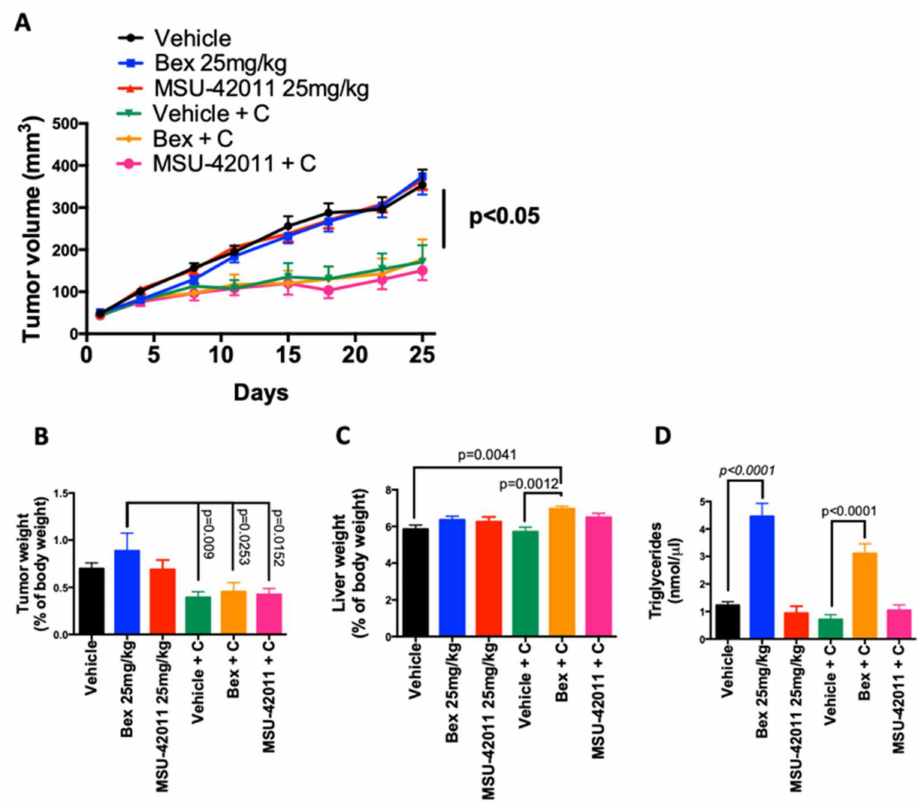
Figure 6. RXR agonists do not inhibit tumor growth in an A549 xenograft cancer model. Male nude mice were injected in the flank with human A549 lung cancer cells. When tumors reached 4 mm in diameter, mice were treated for 4 weeks with either vehicle control or RXR agonists [25 mg/kg bexarotene (bex) or MSU42011] 5 days per week, alone or in combination with carboplatin (C, 15 mg/kg) once per week. Tumors were measured with calipers two times per week. n = 7 mice per group ( A ) Evolution of A459 xenograft tumor growth over time. ( B ) Tumor and ( C ) liver weights ( n = 7/group) and ( D ) triglycerides levels in plasma ( n = 5) at the time of